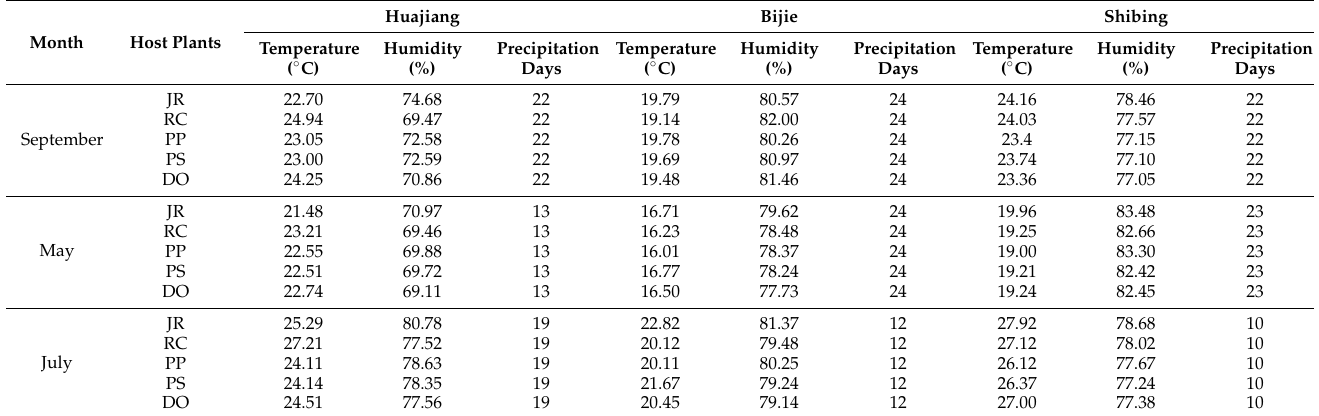
Table 2. Climate data in each plot ((JR): Juglans regia , (RC): Rhus chinensis , (PP): Prunus persica , (PS): Prunus salicina , and (DO): Debregeasia orientalis